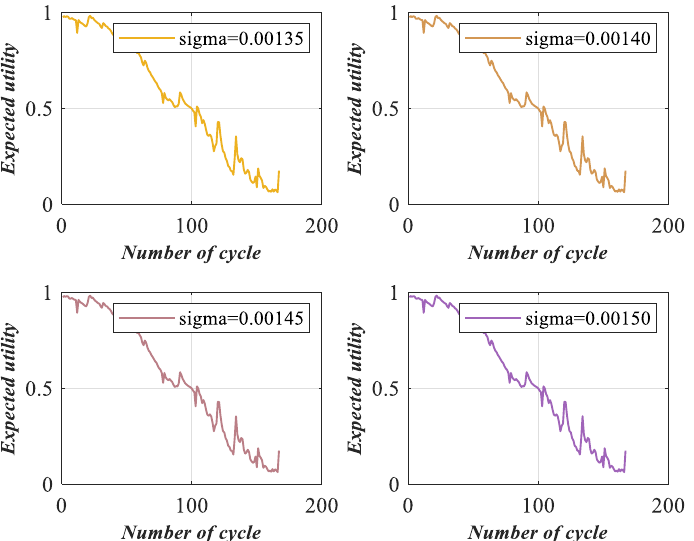
Figure 17. Expected utility of lithium-ion battery health status under different perturbation intensities.